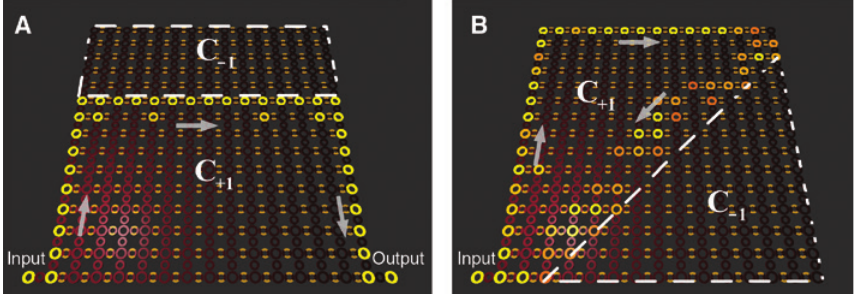
Figure 5: Field distributions inside 15 × 15 resonator array for spatially distributed applied power (50 mW input power regions outlined by shadowing), which leads to spatially distributed topologically protected states (1) (A) Straight, vertical virtual boundary between topological insulators; and (B) an input power of 50 mW applied to each heating element positioned below the main diagonal of the array.